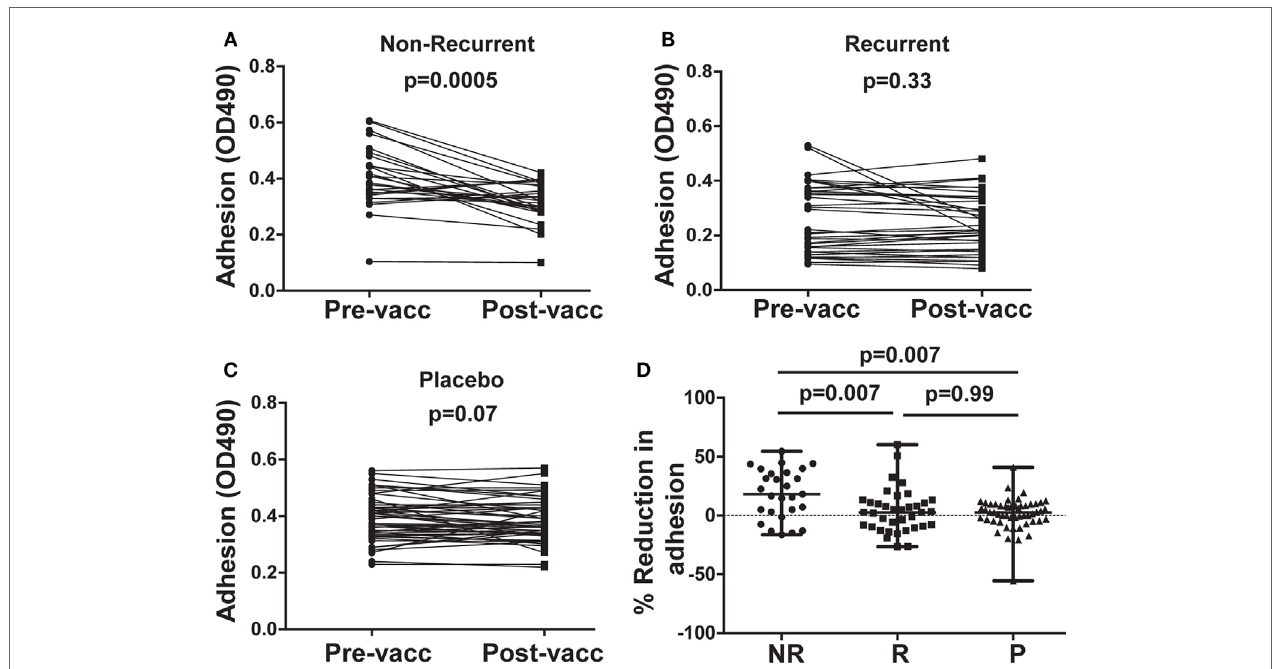
FigUre 2 | In vitro assessment of Candida albicans adherence to plastic in presence of patient sera. Post-vaccination sera from 27 non-recurrent (NR) patients significantly ( p = 0.0005) reduced C. albicans adhesion when compared to their respective pre-vaccination sera (a) . There was no difference in the extent of adhesion between pre- and post-vaccination sera from 37 recurrent (R) patients ( p = 0.33) (B) , or 53 placebo (P) patients ( p = 0.067) (c) . Percent inhibition of C. albicans adhesion to plastic was significantly higher in post-vaccination sera of NR patients vs. that of R or P patients (D) . Data in (D) are presented as median ± interquartile range. Each dot represents alteration in C. albicans adhesion due to an individual patient